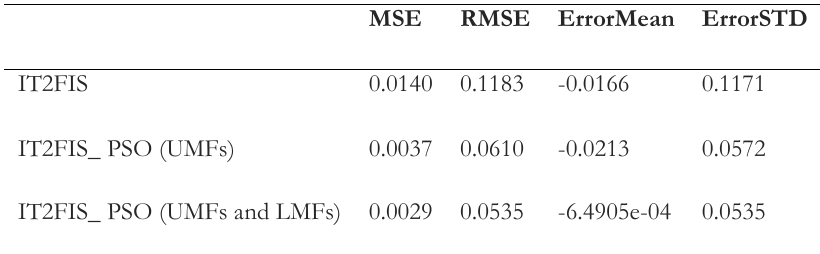
Table 6. An overview of the results of the proposed